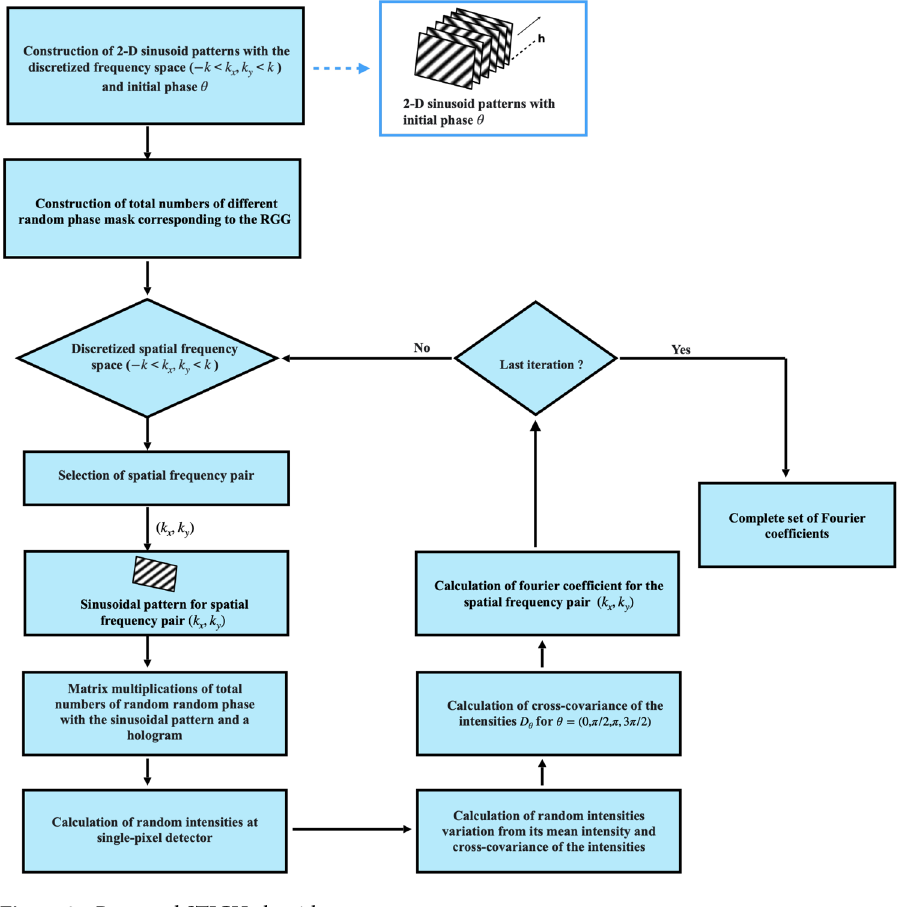
Figure 3. Proposed STICH algorithm